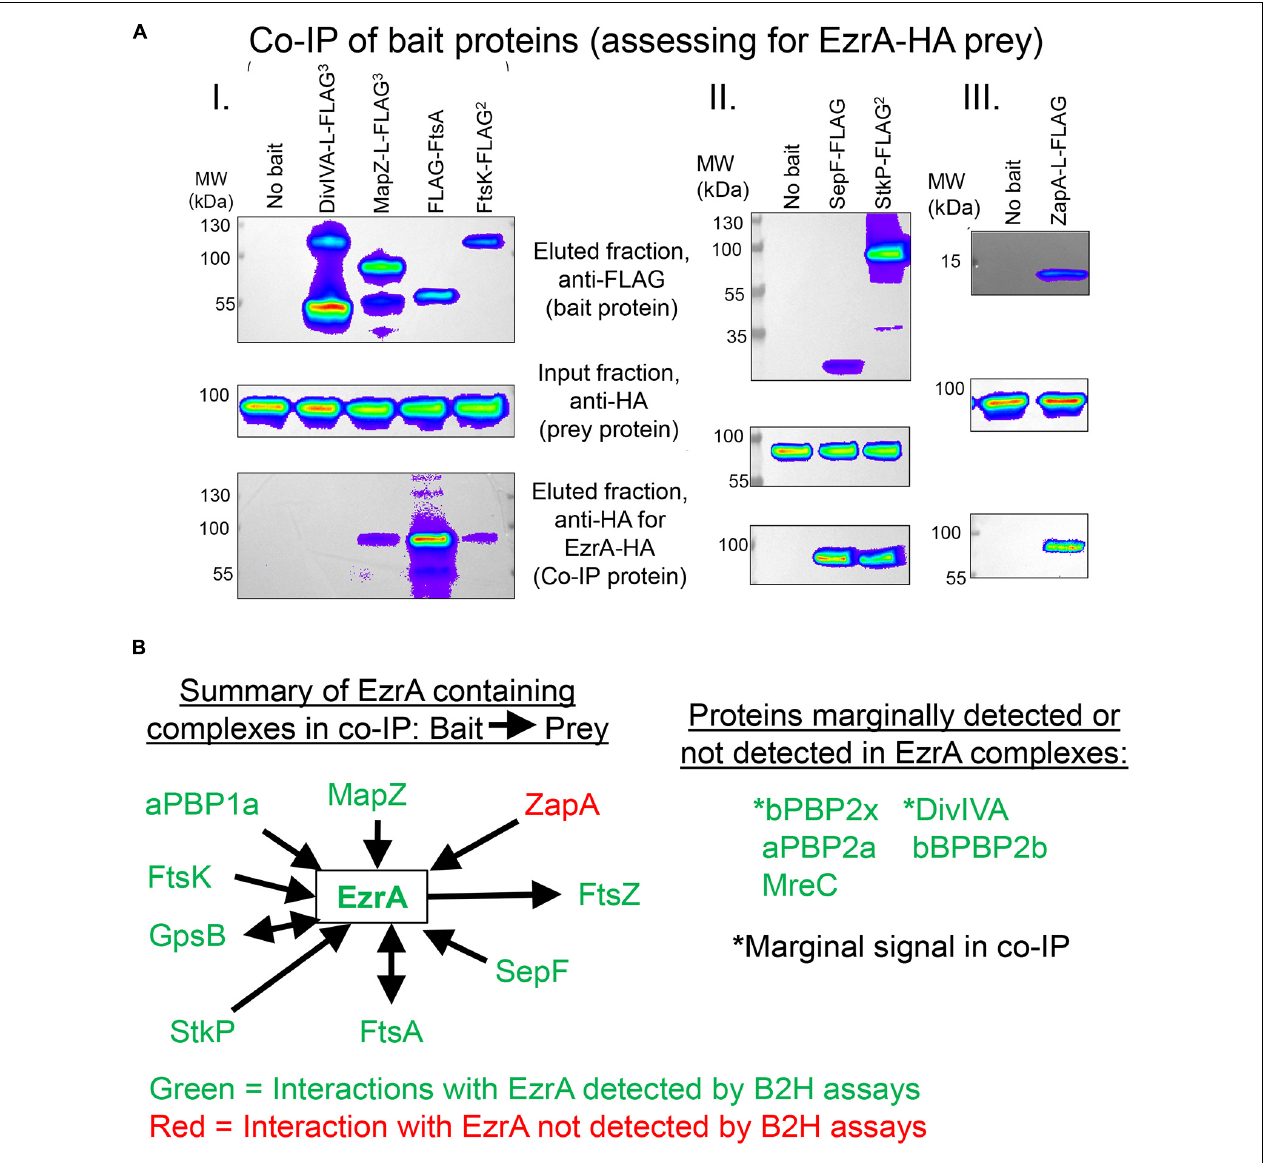
FIGURE 9 | EzrA is in complex with Z-ring regulators and cell-cycle regulators. Associations of EzrA with FtsZ-ring regulators (MapZ, FtsA, SepF, ZapA) and cell-cycle regulators (DivIVA, FtsK, StkP) in Spn were tested by co-IP in (A) and (B) or B2H in (B) . Experiments are representative from two independent biological replicates. (A) Top panels, labeling of transferred membranes with anti-FLAG in the eluted fractions shows the presence of FLAG-tagged bait protein. Middle panels, labeling with anti-HA in the input fraction shows the presence of EzrA-HA. Bottom panels, labeling with anti-HA in the eluted fraction shows if EzrA-HA was associated with the bait protein. Strains were subjected to Co-IP and Western blotting as described in section “Materials and Methods.” Complete genotypes are listed in Supplementary Table 1 . (I) “No bait” (IU9713), DivIVA-FLAG 3 (IU11414), MapZ-FLAG 3 (IU11430), FLAG-FtsA (IU11476), FtsK-FLAG 2 (IU11664. (II) “No bait” (IU6810), SepF-FLAG (IU12076), or StkP-FLAG 2 (IU12077). (III) “No bait” (IU11939) and ZapA-FLAG (IU11840). (B) Summary of EzrA co-IP results and pairwise B2H interaction assays. See Tables 2 , 3 for quantitation and tabulation of co-IP results. See Supplementary Figure 21 for B2H